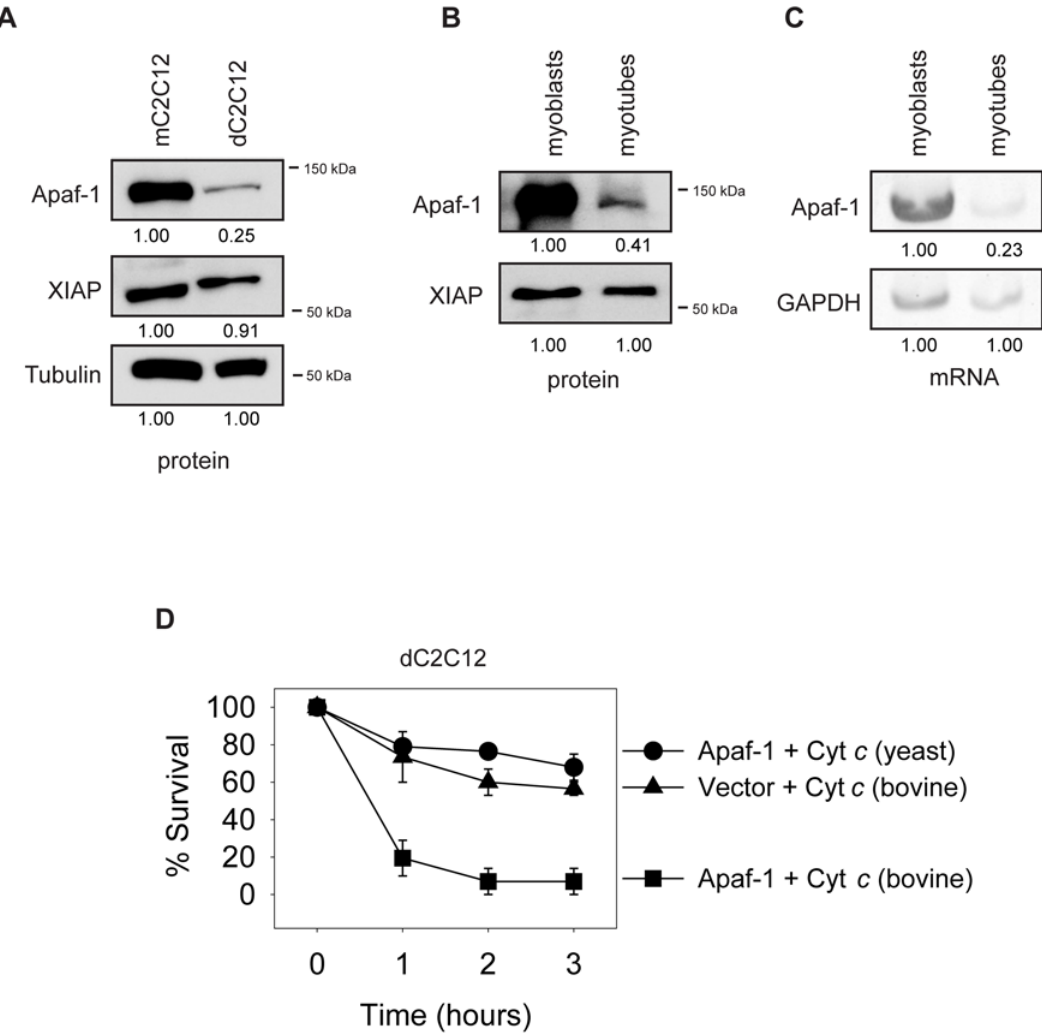
Figure 3. Apaf-1 levels are decreased in myotubes. Restoring Apaf-1 is sufficient to allow cytochrome c -mediated death. (A) Levels of the indicated apoptotic proteins were examined by Western blot of whole cell lysate from mC2C12 and dC2C12 cells. Tubulin serves as a loading control. Densitometry of protein levels are normalized to loading control protein levels of the representative Western blot. (B) Levels of the indicated apoptotic proteins were examined by Western blot of whole cell lysate from primary myoblasts and primary myotubes. Densitometry of protein levels are normalized to loading control protein levels of the representative Western blot. (C) RT-PCR was carried out with primers for the indicated mRNA using RNA from primary myoblasts and myotubes. GAPDH serves as a control. Densitometry of Apaf-1 mRNA levels are normalized to GAPDH levels of the representative gel. (D) dC2C12 cells were injected with plasmids for either Apaf-1 (Apaf) or empty vector as well as GFP. 24 h following injection, GPF positive cells were injected with rhodamine dextran and either yeast or bovine cytochrome c . Cell survival was assessed by morphology at the indicated times following cytochrome c injection. Data are the mean 6 SEM of n $ 3 separate experiments per time point.